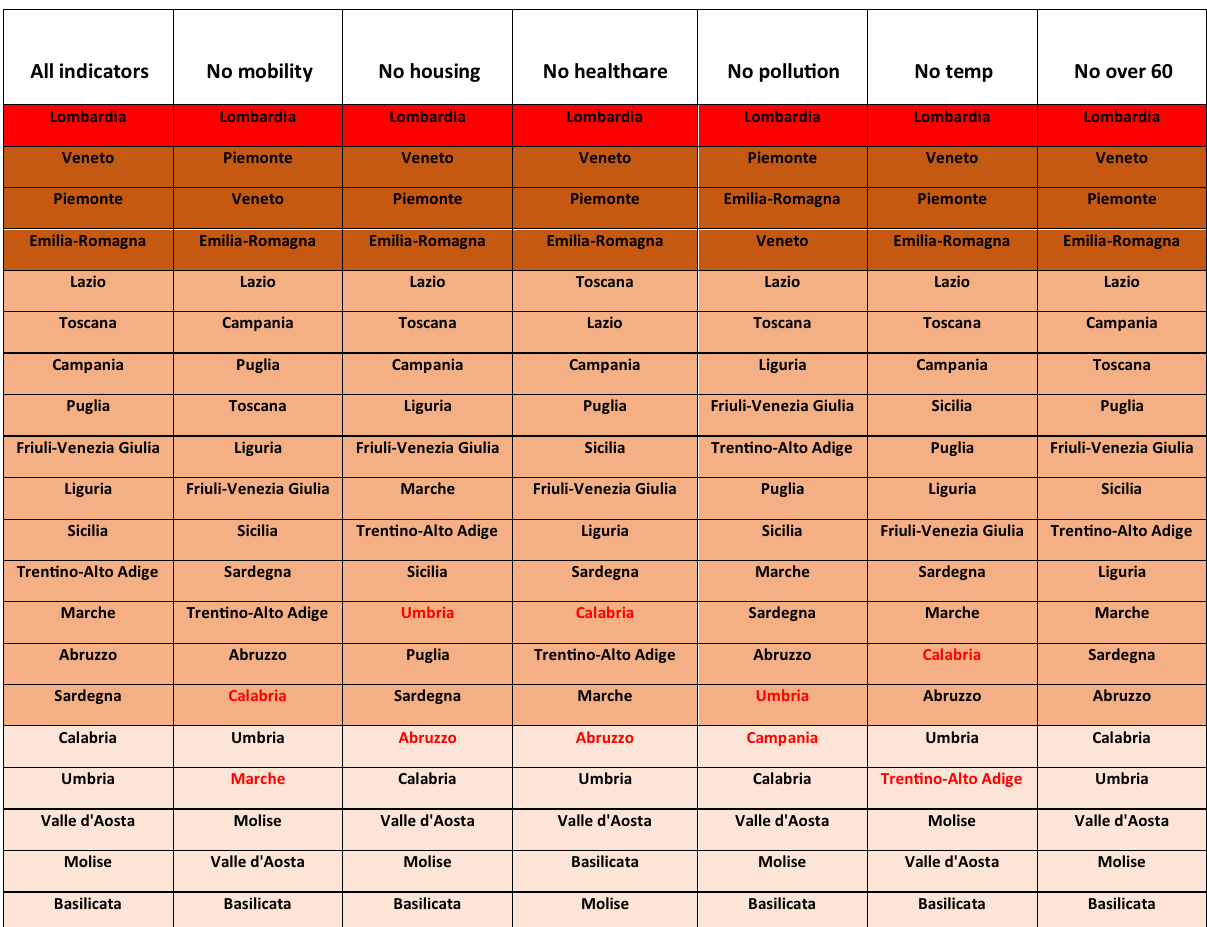
Table 6. Robustness of the a-priori risk ranking, shown in Fig. 3a of the main text, under elimination of single indicators from the risk index definition. The composition of the four risk groups seems to remain